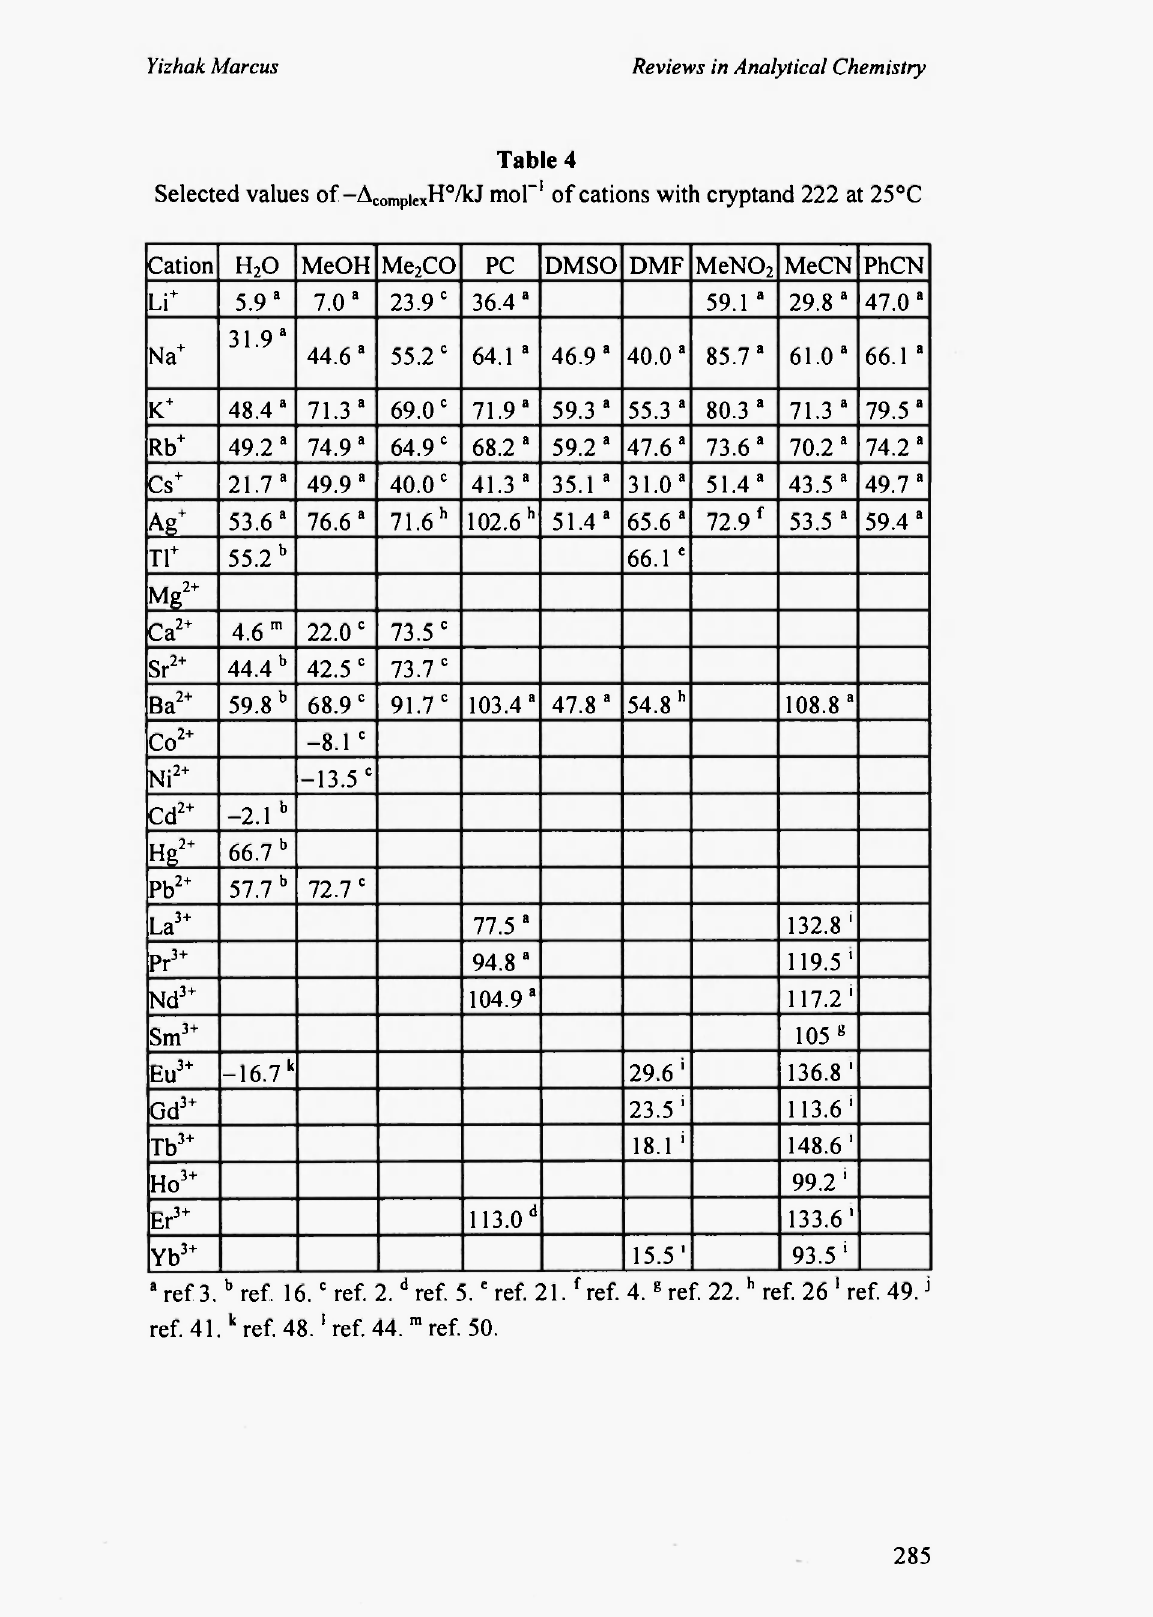
Selected values of-A comp | ex H°/kJ mol -1 of cations with cryptand 222 at